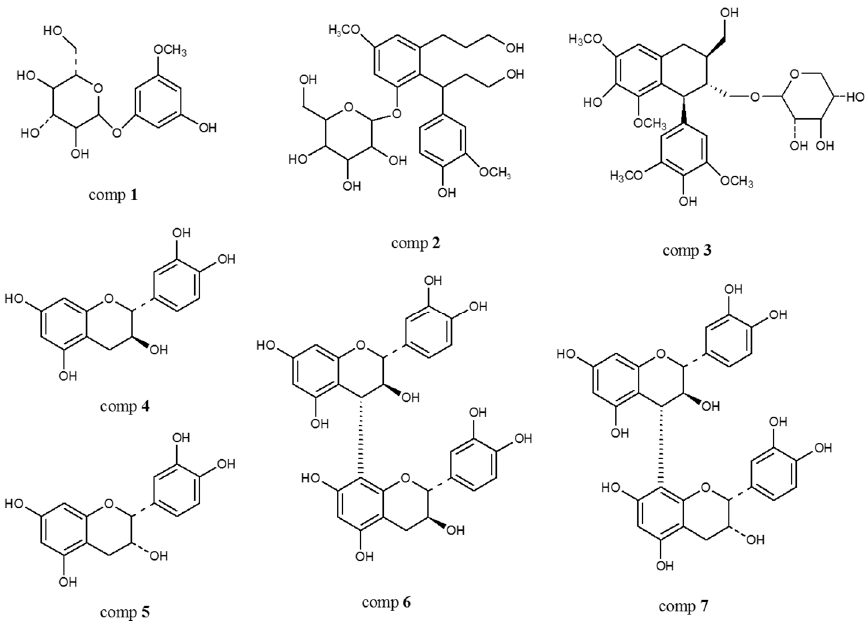
Figure 1. Structures of QGB compounds 1 – 7 .